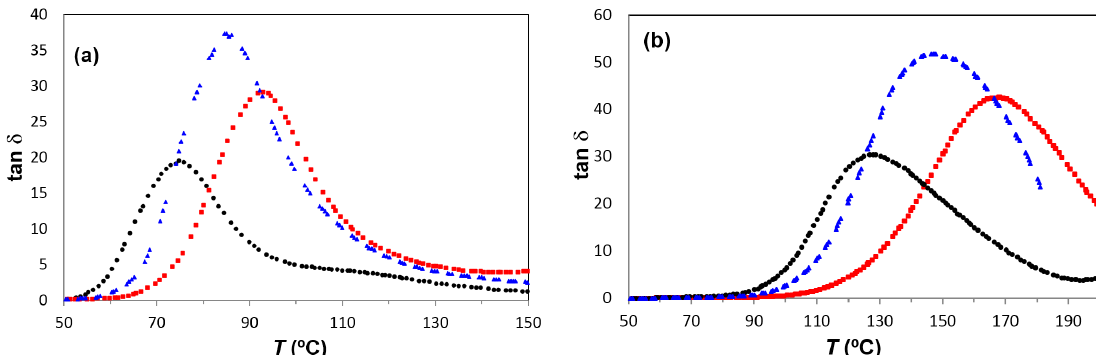
Figure 11. Dielectric relaxation spectroscopy curves for the α -relaxation for the different samples studied: PEI2000-PLA5 (black circles), PEI2000-PLA20 (red squares) and PEI800-PLA5 (blue triangles), at frequencies: ( a ) 1 Hz; ( b ) 1 kHz. Heating rate: 0.5 °C/min.